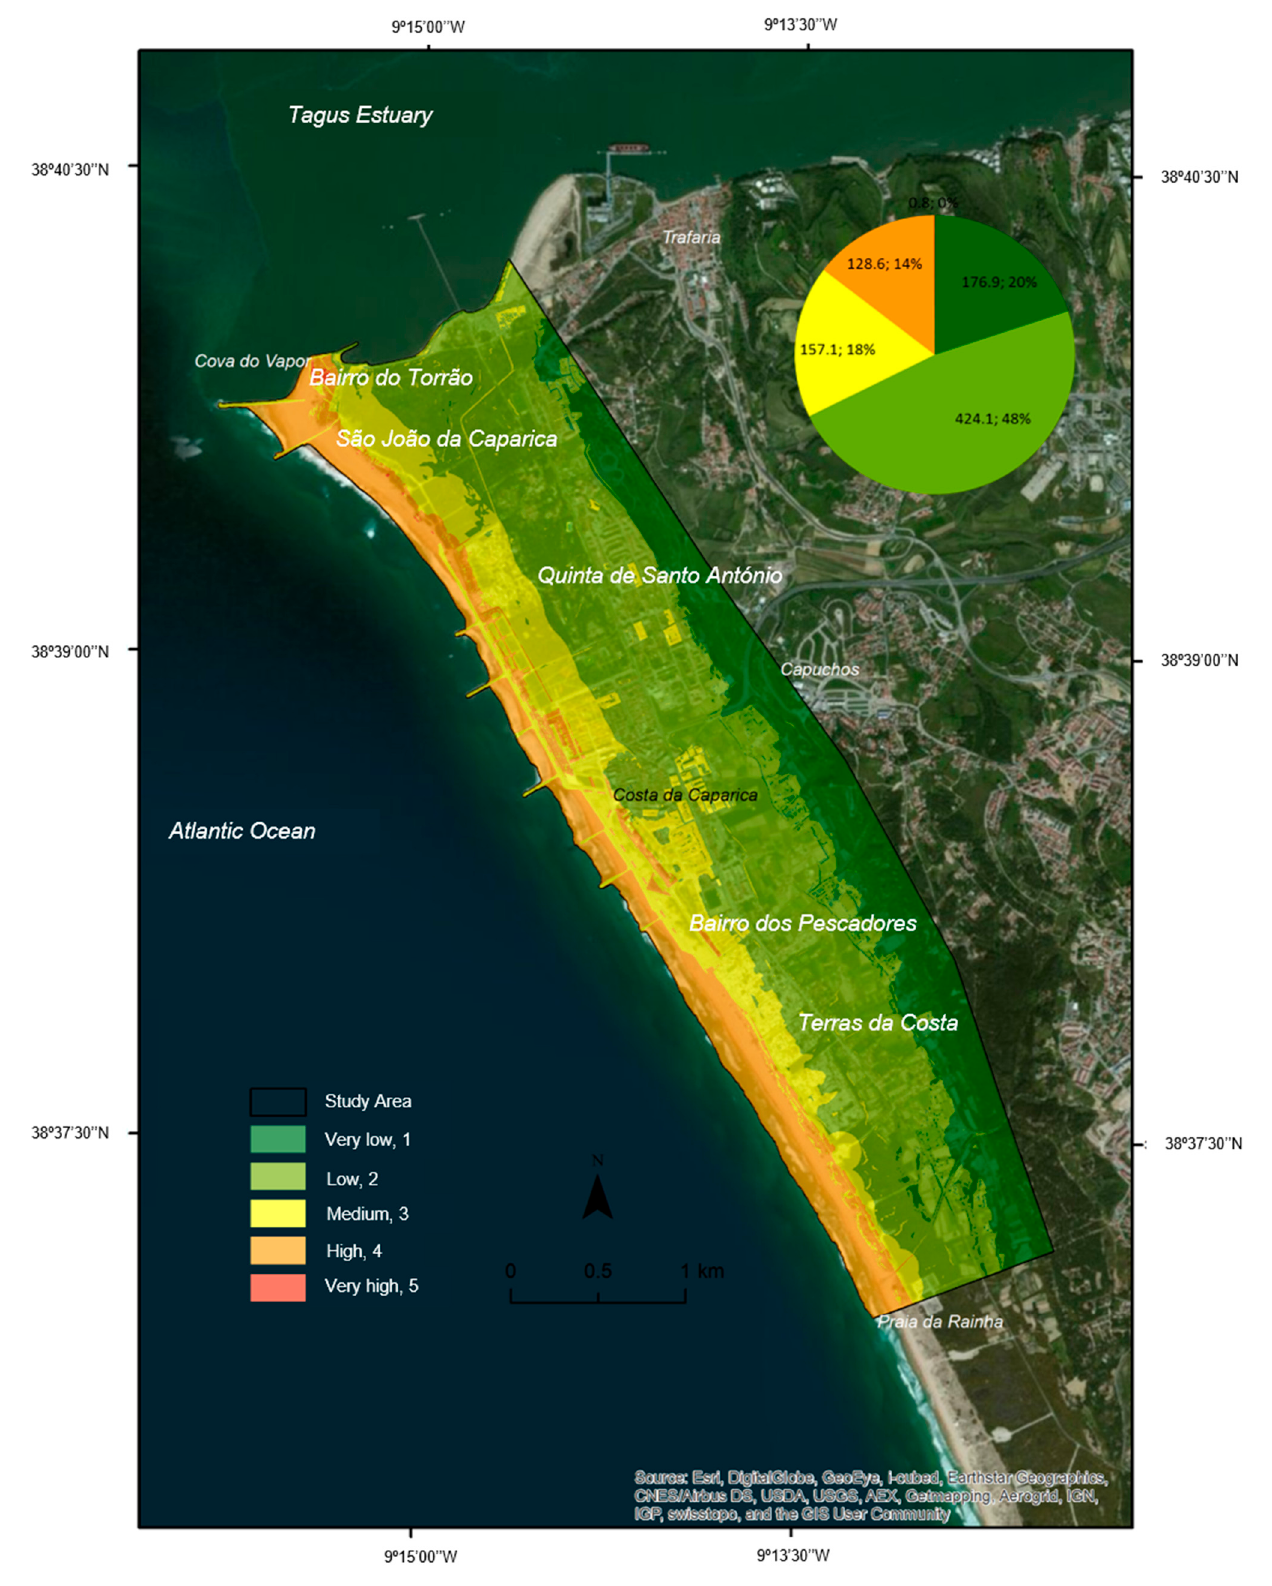
Figure 6. Map of the risk index to coastal overtopping and consequent flooding in the study area, Costa da Caparica, with the graph of the areas (ha) and percentages of each risk class. The coordinate system used was Datum73 Transverse Mercator.